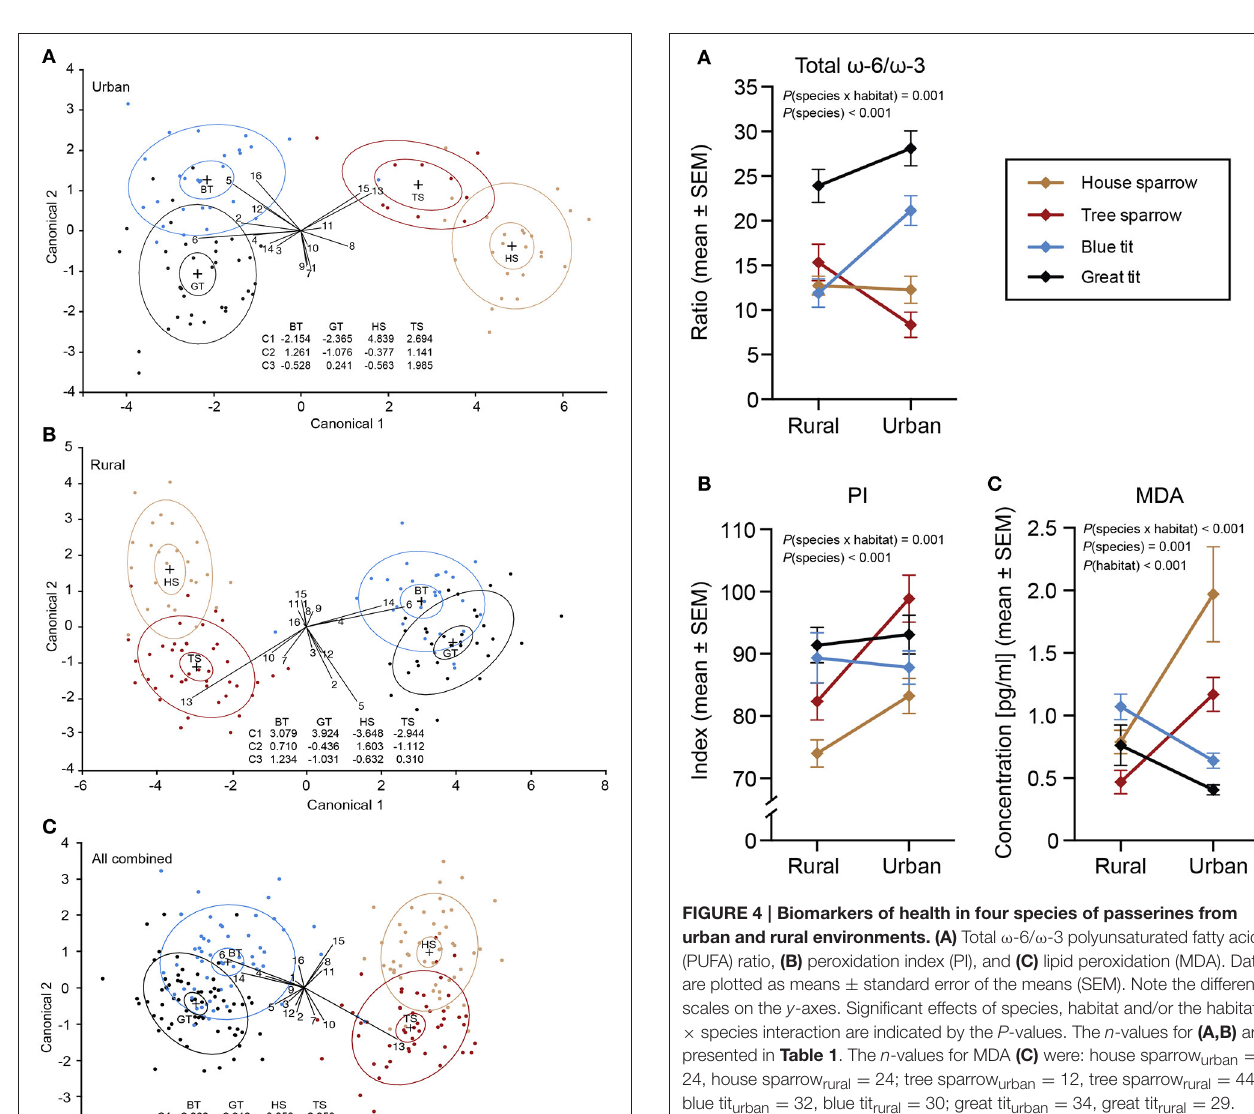
significantly higher in the two tit species than in the sparrows ( P < 0.05 in all cases; Figures 1C,E ). Finally, the ω -6 PUFA, arachidonic acid, differed significantly between species [ F (3, 220) = 35.90, P < 0.001], with the two tit species having higher proportions than the two sparrow species ( P < 0.05 in all cases; Figure 2I